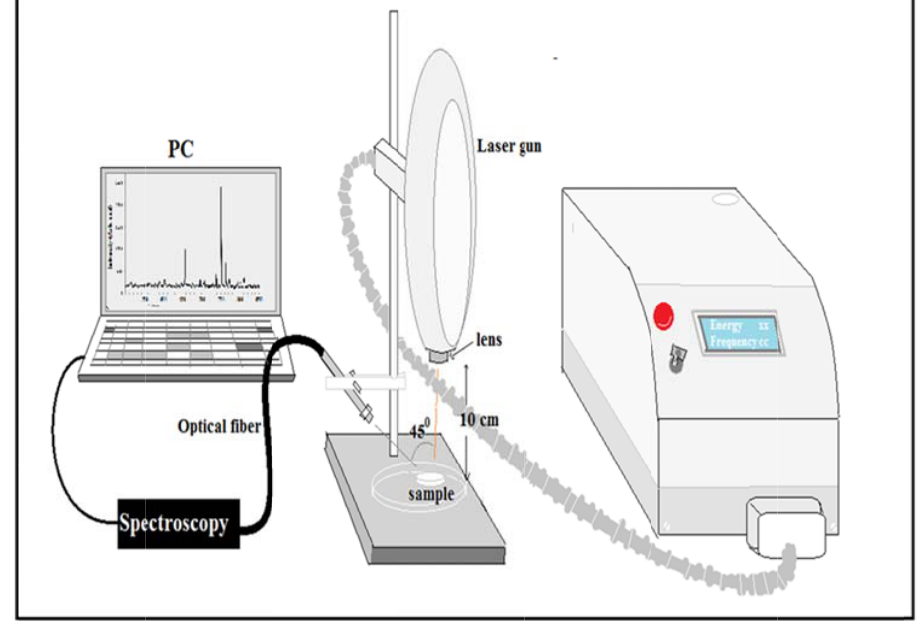
Fig.1: La The spectro ng the light ctrometer w